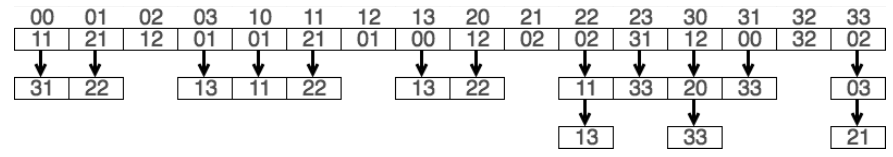
Figure 3: PRTL implementation. Same points stored as in Figure 2.